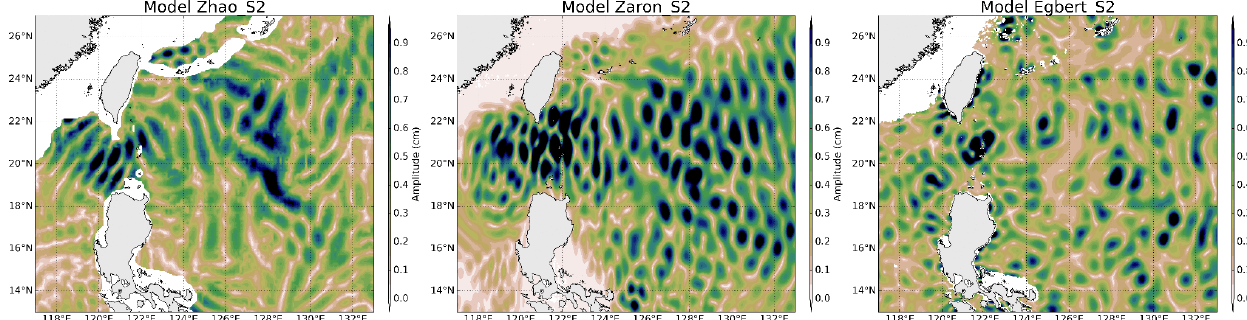
Figure A2. Amplitude of the IT models for the S 2 tide component in the Luzon area.